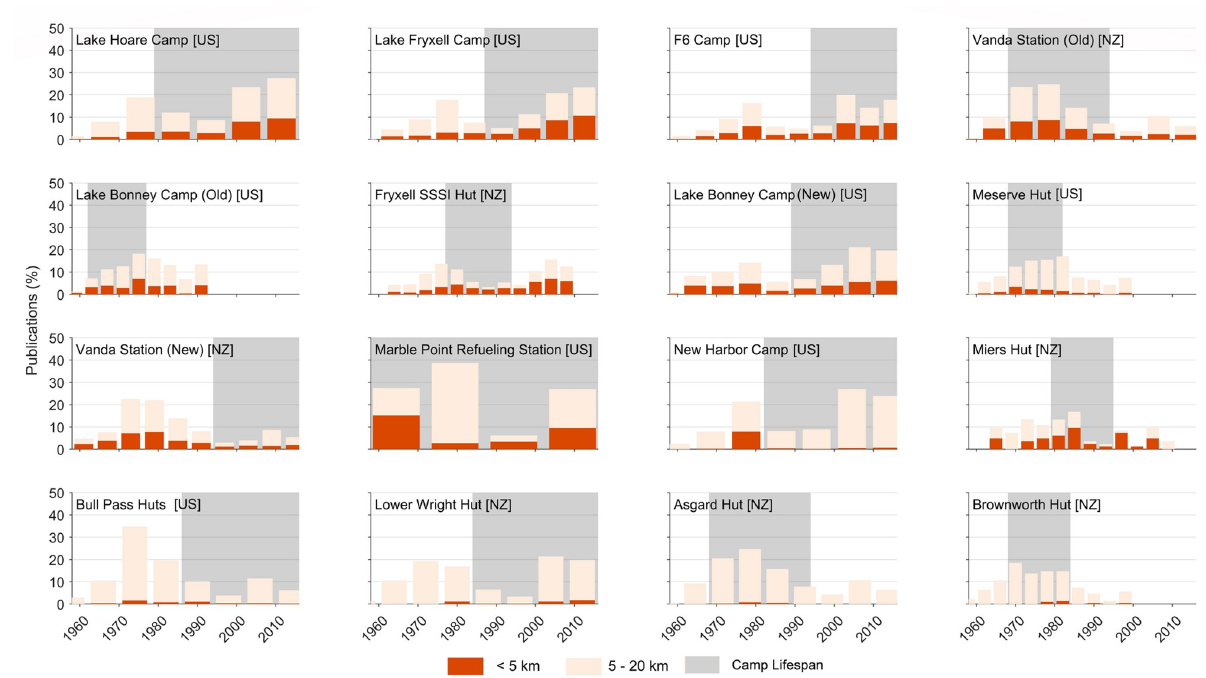
Fig 6. Percentage of publications within 5 km and 5–20 km of each field camp, relative to the total number of publications within 20 km of the camp from 1958–2016. Gray shading indicates the lifespan of each camp and bar widths correspond to quartiles based on this lifespan. Field camps are sequentially ordered (left to right) based on how many publications were counted within 5 km of them during their lifespan. Field camps managed by New Zealand (NZ) and the United States (US) are indicated in brackets.